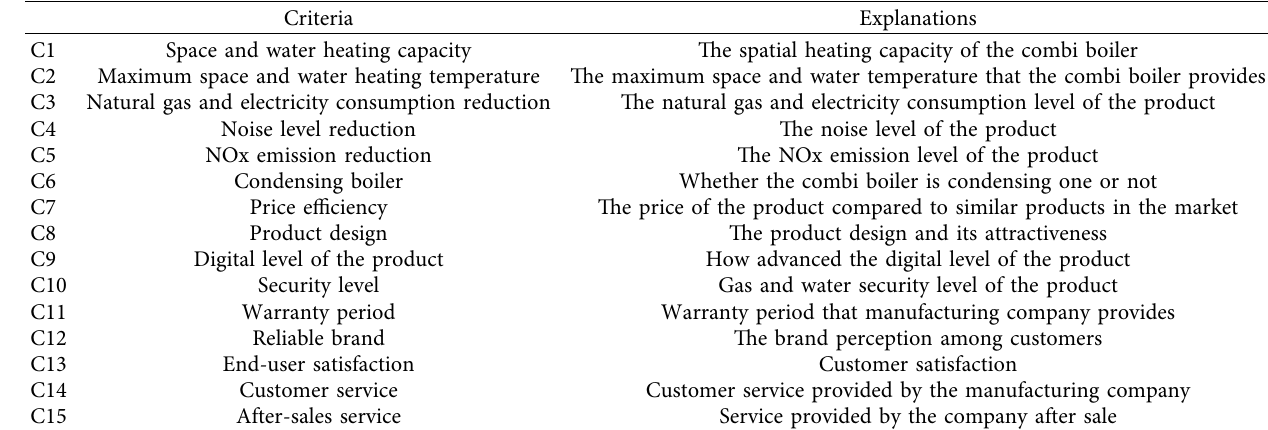
Table 3: Evaluation criteria for combi